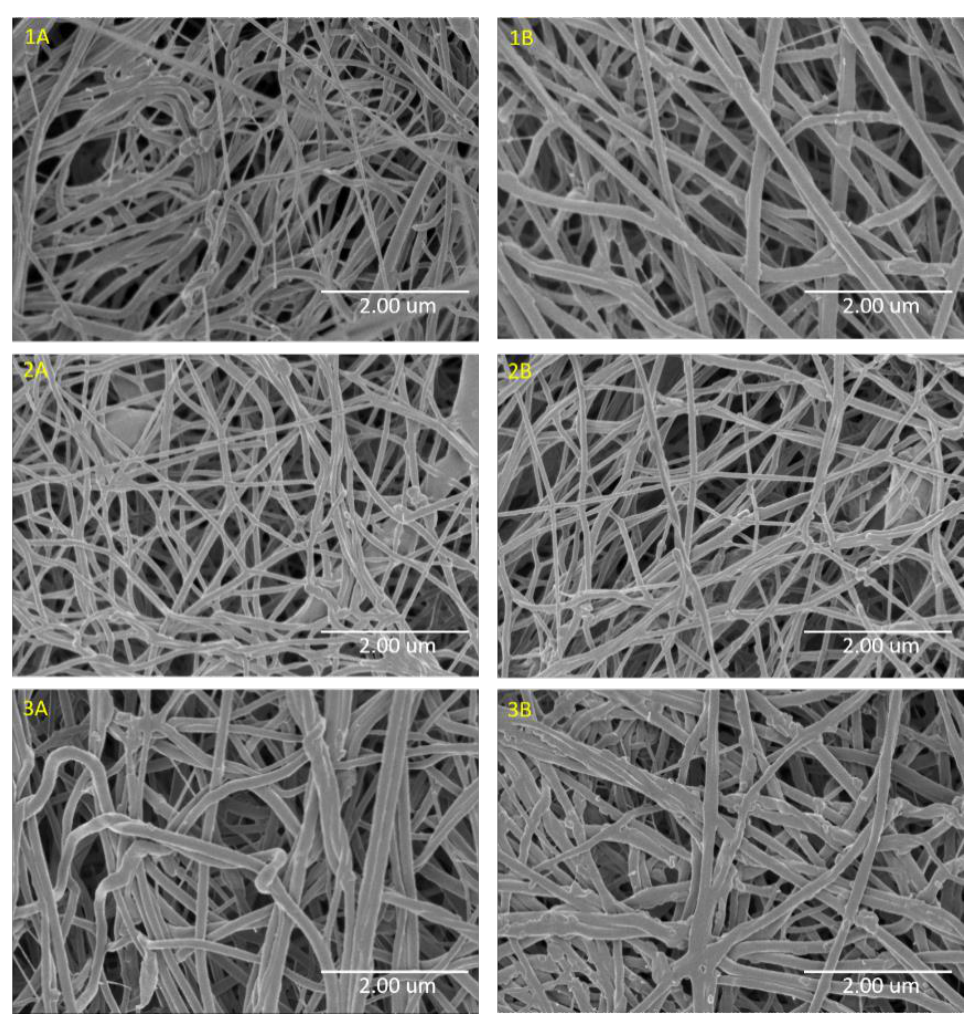
Figure 2. 1 kV SEM images of each PCL/imiquimod nanofiber sample. The images are labeled with the sample name shown in Table